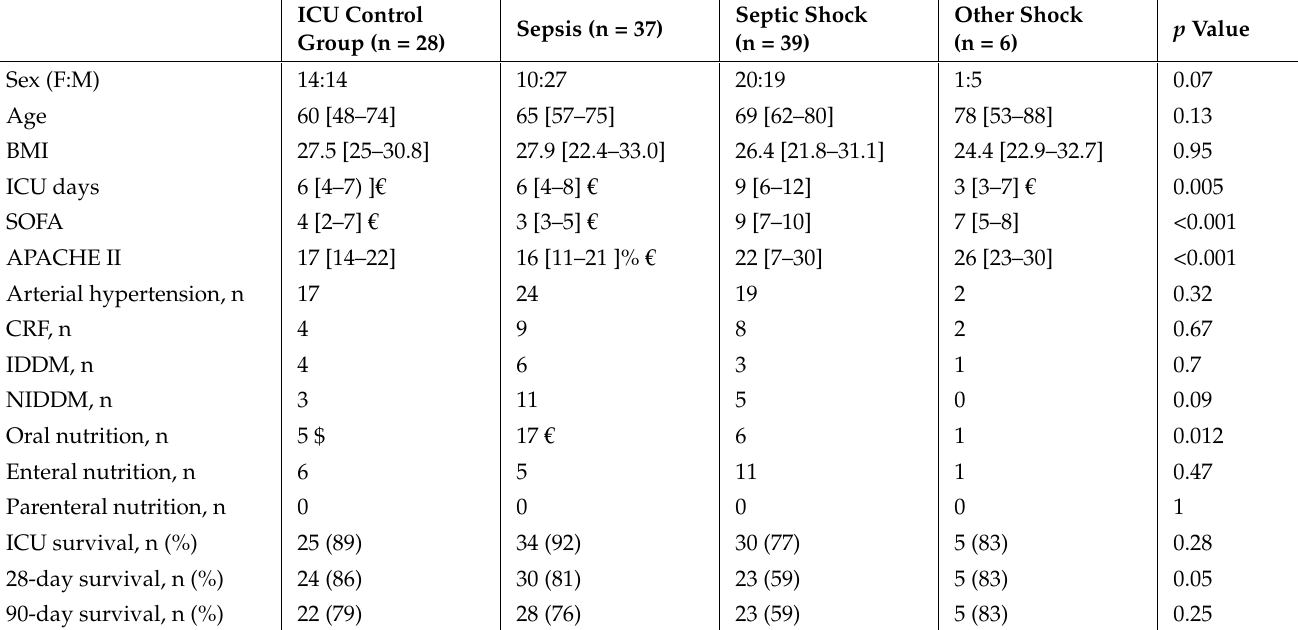
Table 2. Clinical data for each patient group (ICU control group, sepsis, septic shock, other shock). ICU